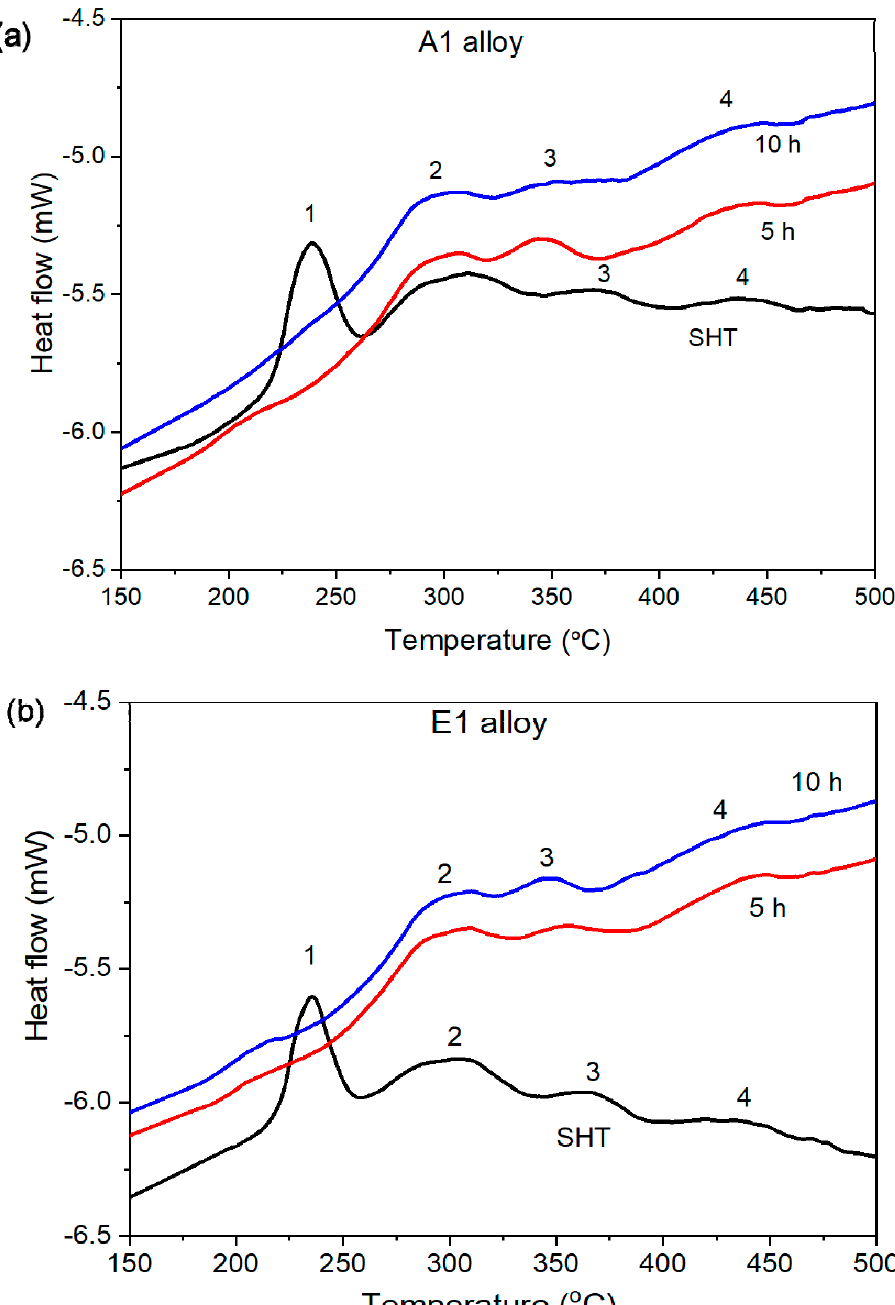
Figure 10. DSC curves of A1 alloy ( a ) and E1 alloy ( b ) in as-quenched (SHT), in peak hardness (5 h) and overaged (10 h) conditions.